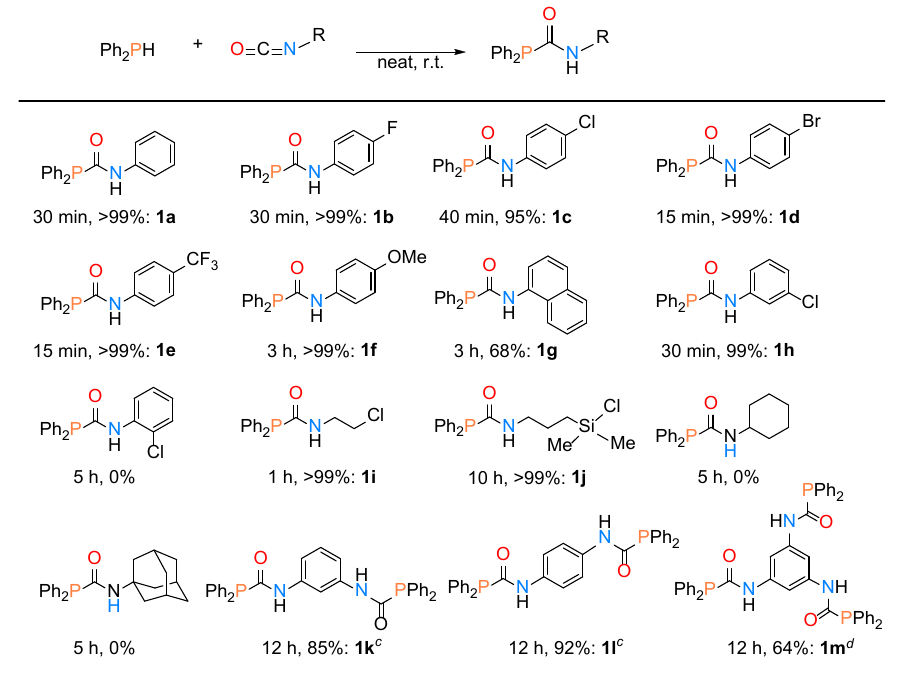
Scheme 2. Scope and limitation for hydrophosphination of isocyanates with diphenylphosphine a,b . a